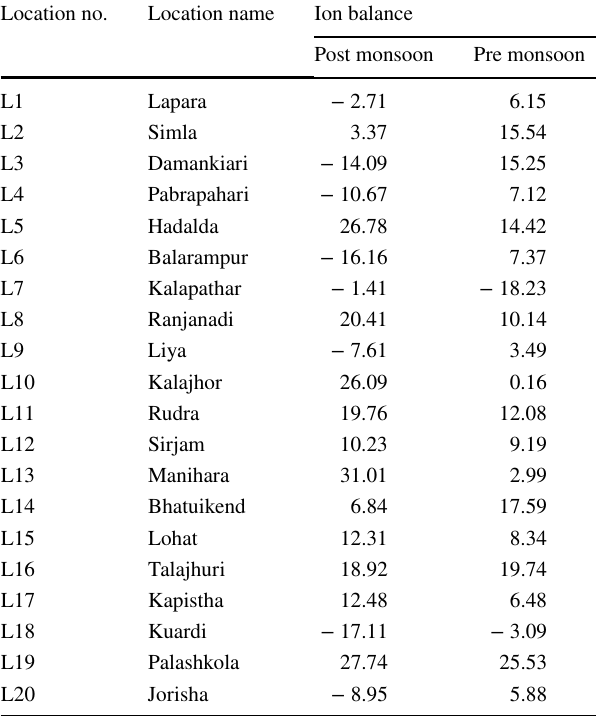
Table 3 Ion balance values of groundwater samples of the study area Location no.